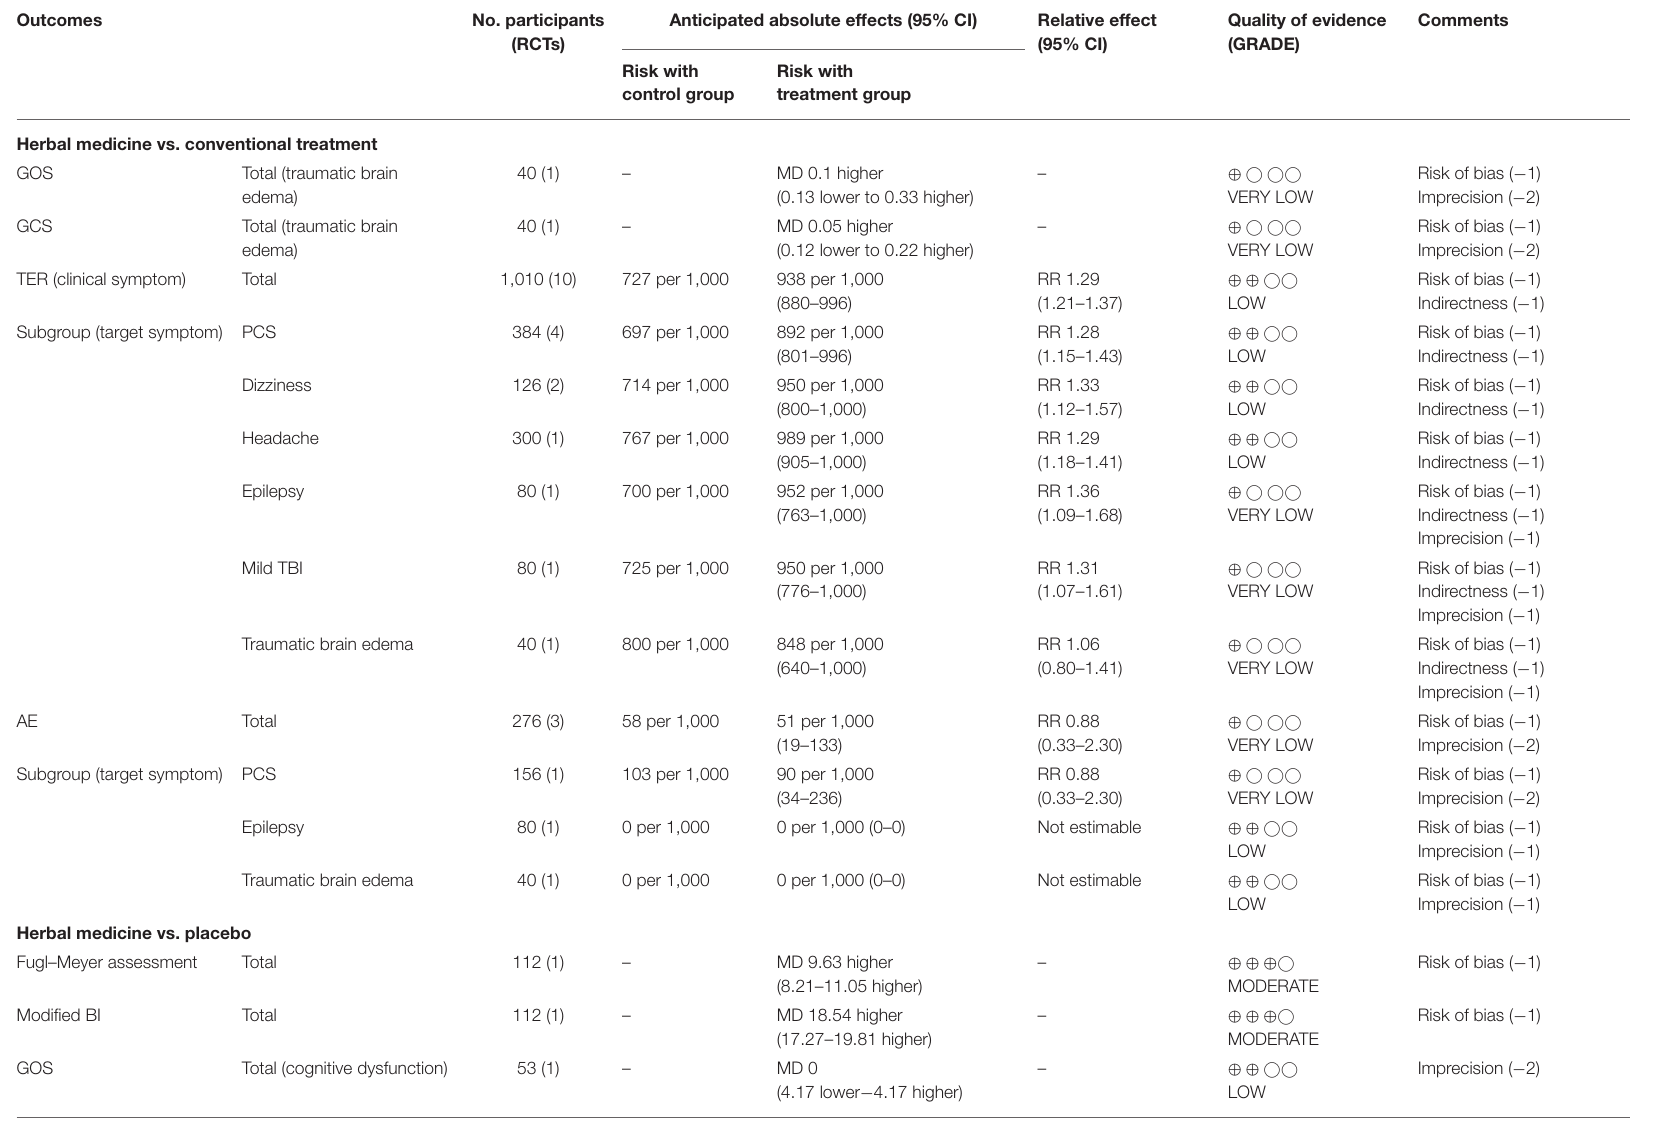
TABLE 2 | Summary of findings in all